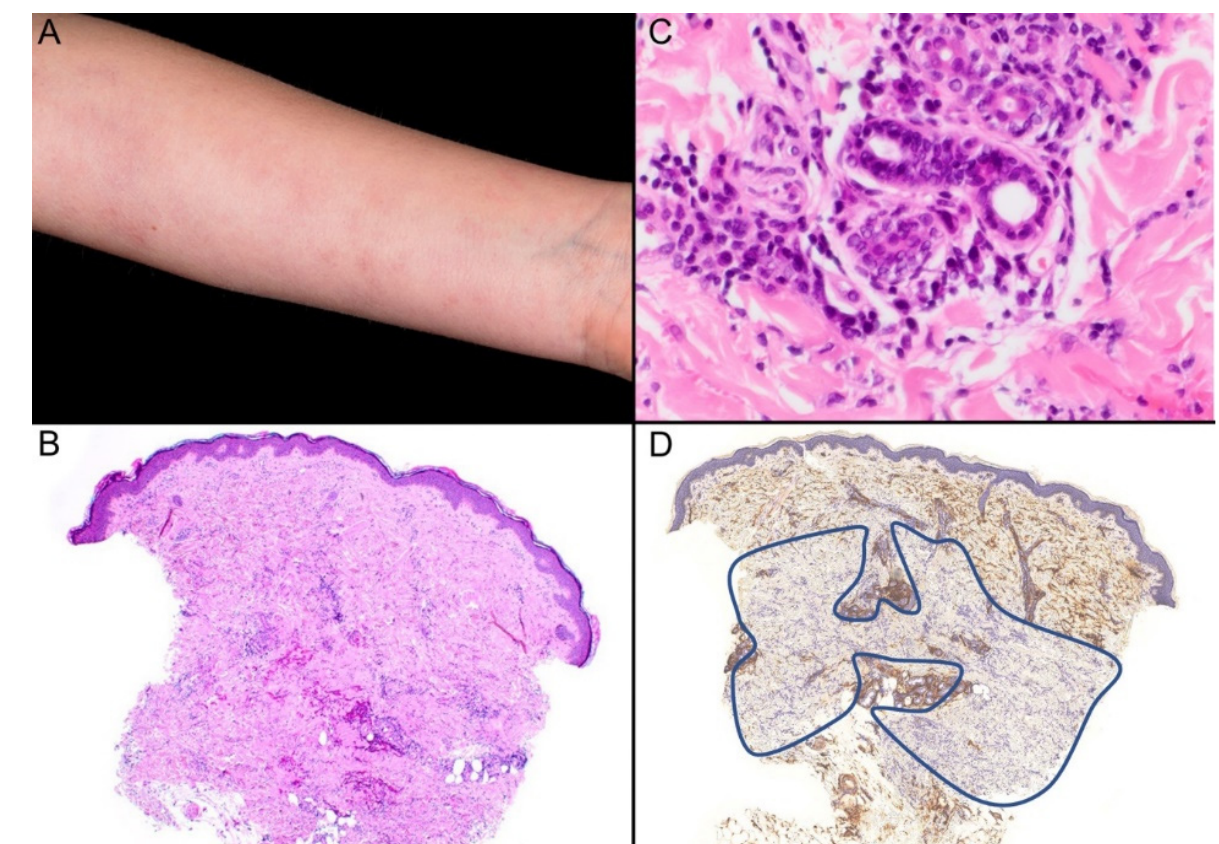
Figure 1. ( A ) Subtle erythematous rash on the forearm in a linear pattern. ( B ) Histopathologic examination of the skin punch biopsy reveals a sparse interstitial inflammatory cell infiltrate. Hematoxylin and eosin, (H&E) ×40. ( C ) Loss of the fat around eccrine glands, mild thickening of the collagen bundles, and a mild lymphocytic inflammatory cell infiltrate with plasma cells (H&E) ×200. ( D ) CD34 expression is reduced in the lower reticular dermis in a geographical pattern (as demarcated by the blue line) ×40.